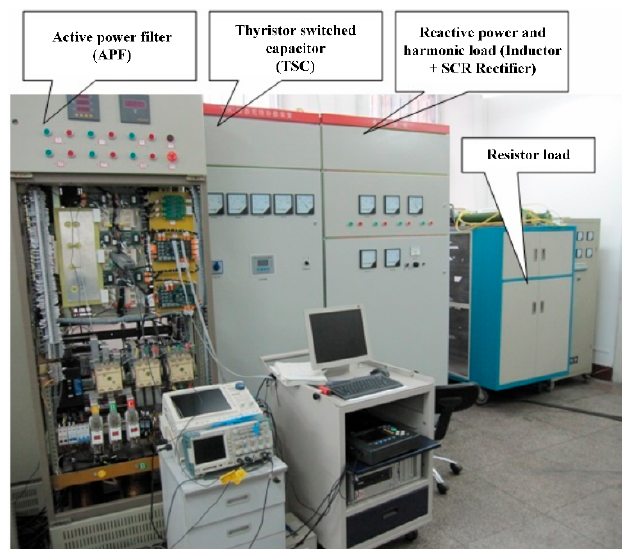
Figure 13. The SAPF prototype in the lab.